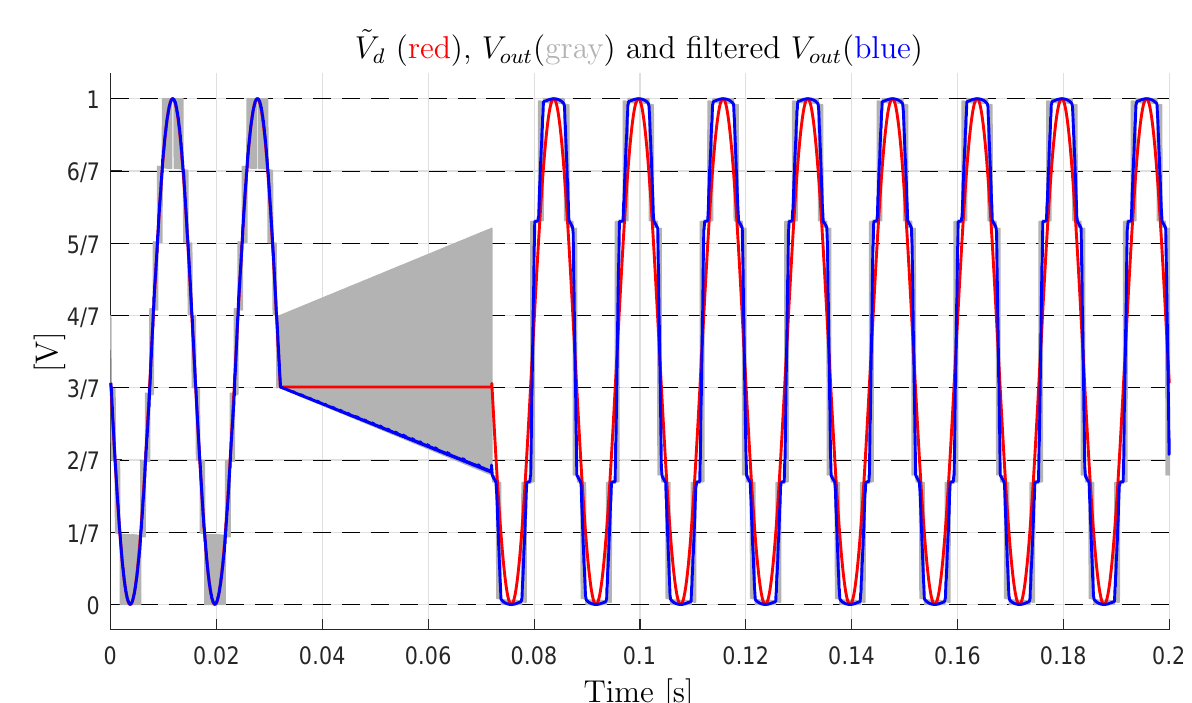
Figure 22. Deformation of the output voltage waveform in the extended operation of the converter with the Configuration Voltage Vector V m = [ 7 6 2 ] T caused by the voltage trajectory divergence in presence of a constant output voltage.